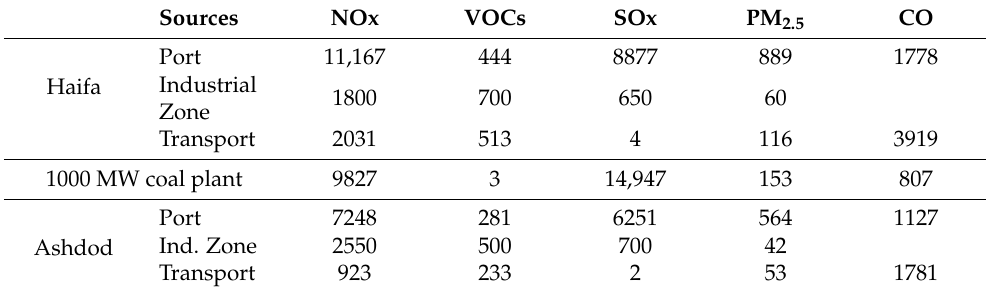
Table A28. Emissions from the Haifa and Ashdod industrial zones and land transportation and a 1000 MW coal power plant.